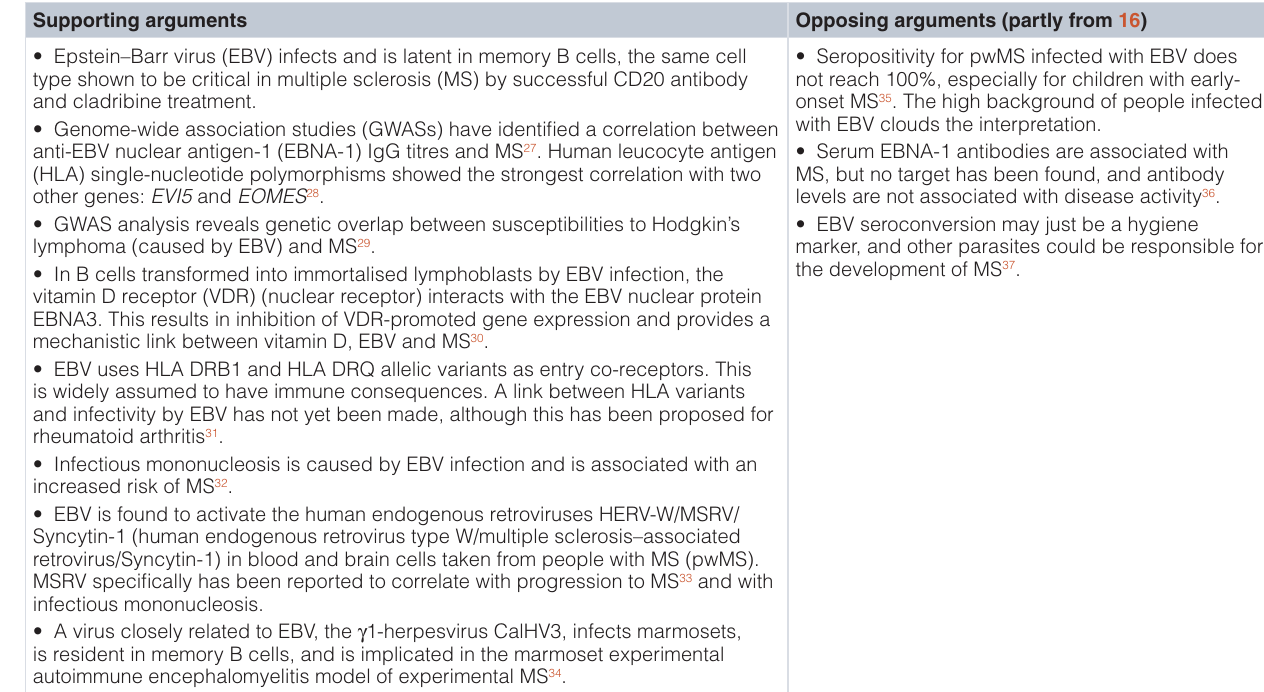
Table 1. Supporting and opposing arguments for EBV involvement in